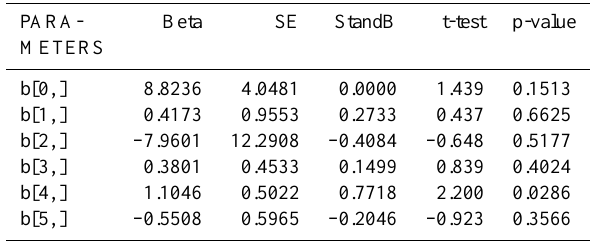
Table 3. The parameters for linear regression obtained by the program XploRe for the input data selected by the proposed GA- ANN method.